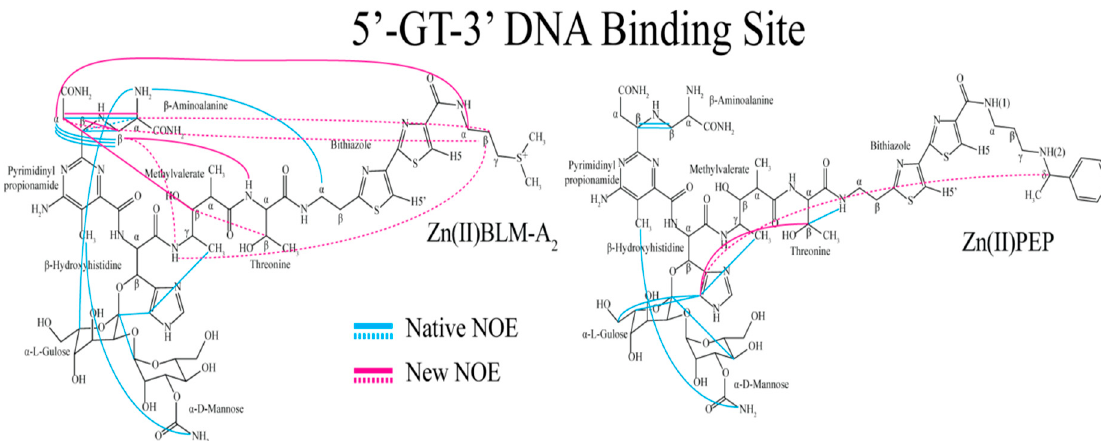
Figure 6. Inter-residue intramolecular NOEs for each OL 2 -bound Zn(II)BLM for samples of Zn(II)BLM:OL 2 in a 1:1 molar ratio in H 2 O at 5 °C. Dashed and continuous lines all represent NOE connectivities, they are used to avoid confusion in busy sectors of the figure.